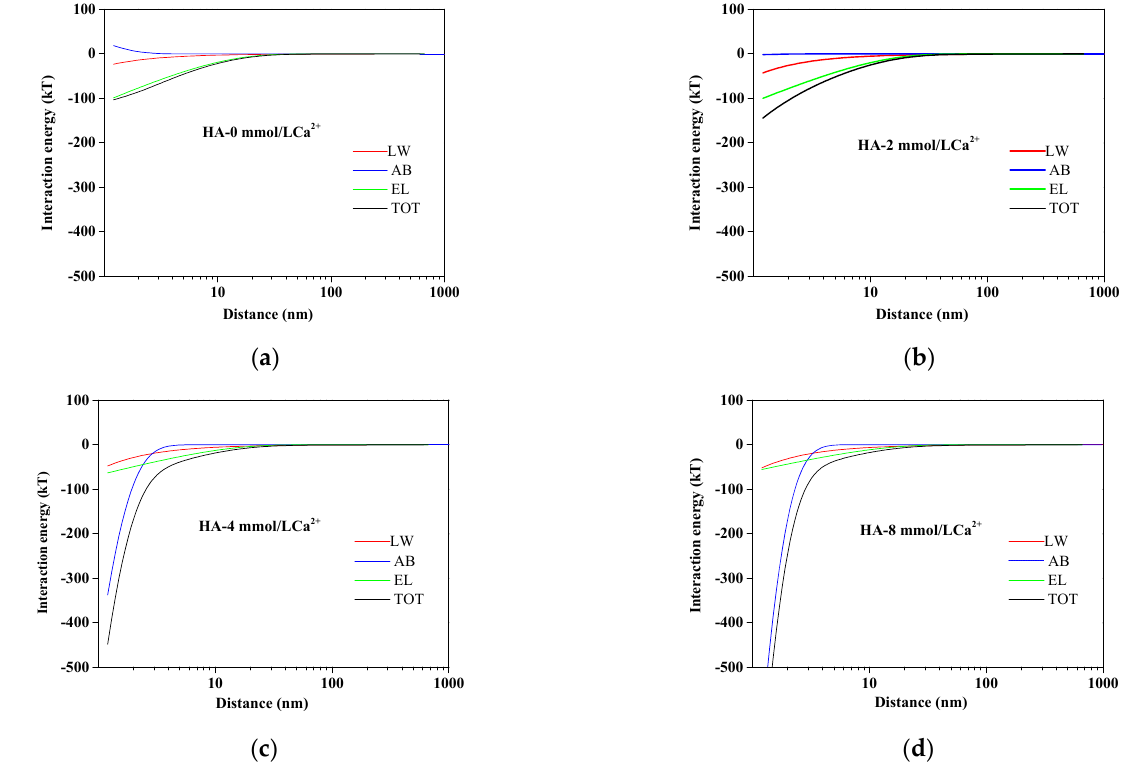
Figure 3. Variation of AEM–HA interaction energy profiles at different calcium ion concentrations: ( a ) HA without Ca 2+ ; ( b ) HA with 2 mmol/L Ca 2+ ; ( c ) HA with 4 mmol/L Ca 2+ ; ( d ) HA with 8 mmol/L Ca 2+ .